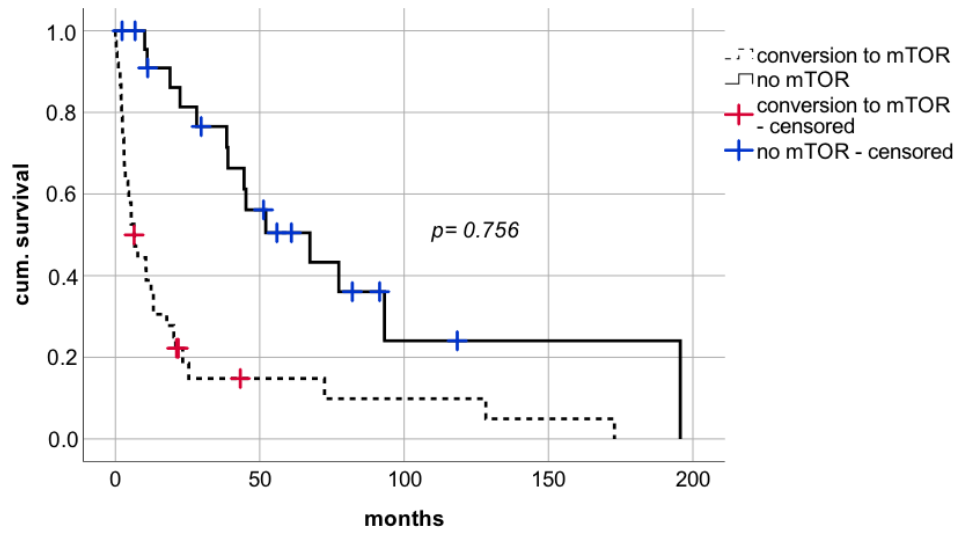
Figure 7. Impact on conversion to mTOR after diagnosis of de novo lung carcinoma after liver transplantation. mTORi—mammalian target of rapamycin inhibitors.